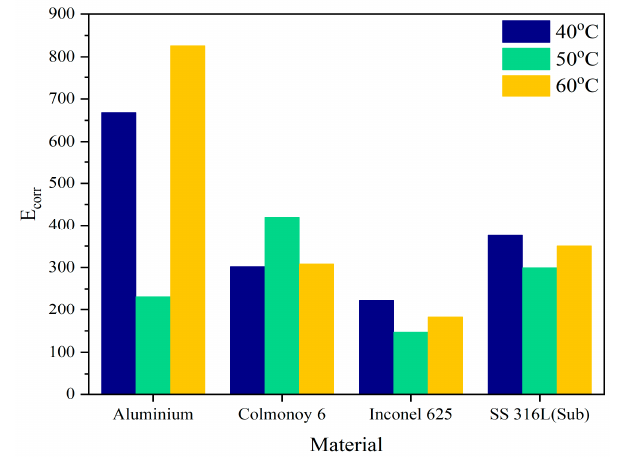
Figure 7. Potential of different coating samples at different temperatures.